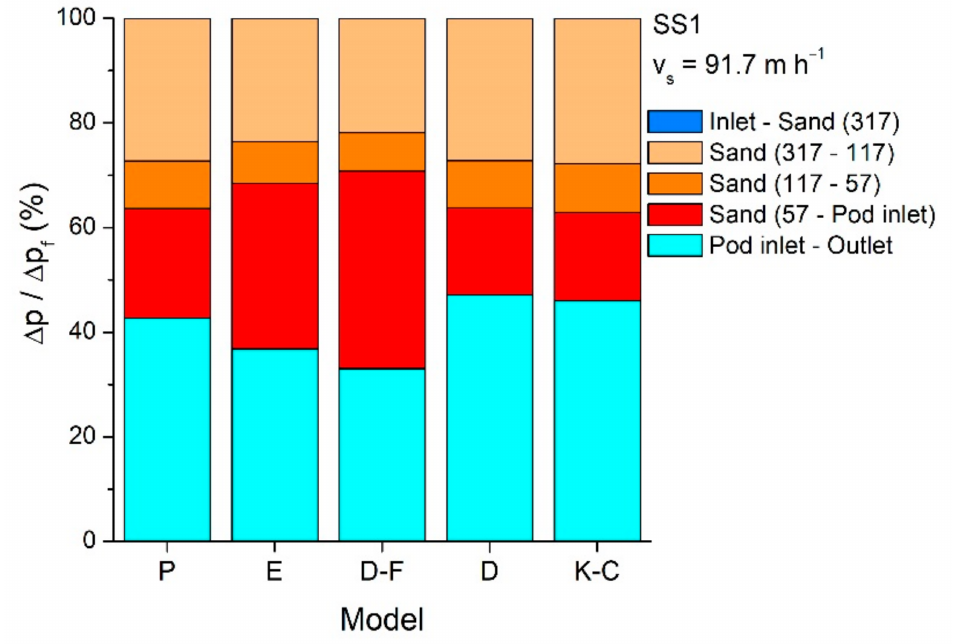
Figure 8. Pressure drop ∆ p at different filter regions normalized to the total filter pressure drop ∆ p f for case h s = 317 mm, Q = 0.8 L s − 1 and SS1 media using different porous media momentum sink equations. P = Power function, E = Ergun, D-F = Darcy-Forchheimer, D = Darcy, K-C = Kozeny- Carman. Numbers in parentheses refer to the vertical height z above the underdrain base plate in